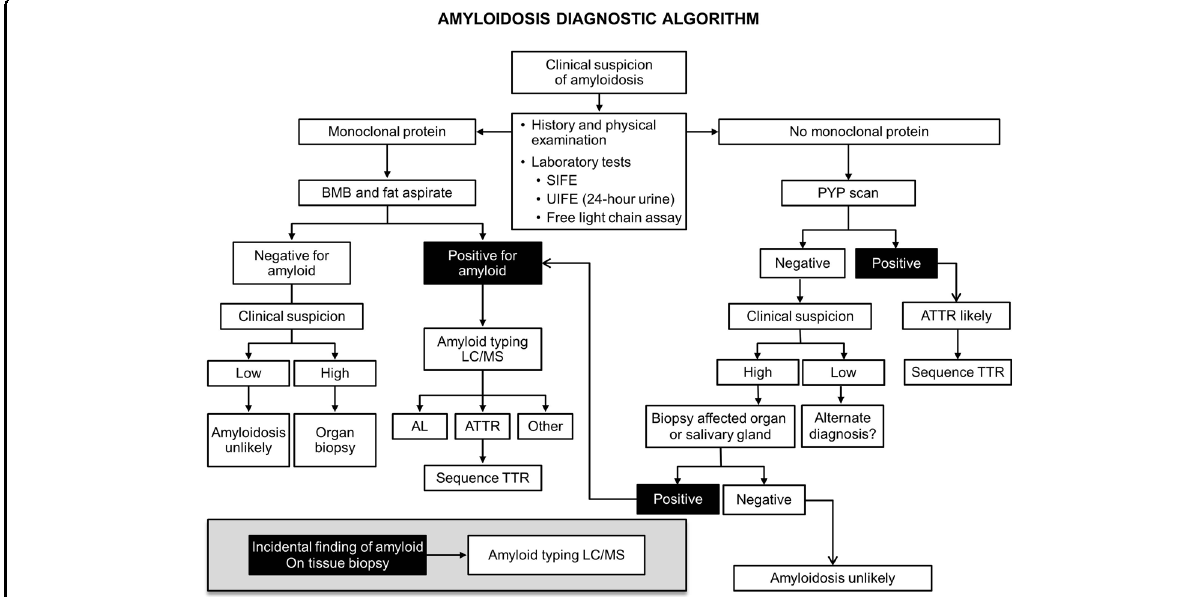
Fig. 1 Diagnostic algorithm for patients that are being evaluated for a syndrome compatible with systemic amyloidosis. ATTR transthyretin amyloidosis, AL immunoglobulin light chain amyloidosis, TTR transthyretin, BMB bone marrow biopsy, SIFE serum immuno fi xation electrophoresis, scintigraphy. Figure reproduced from “ Two types of amyloid in a single patient: a case series ”